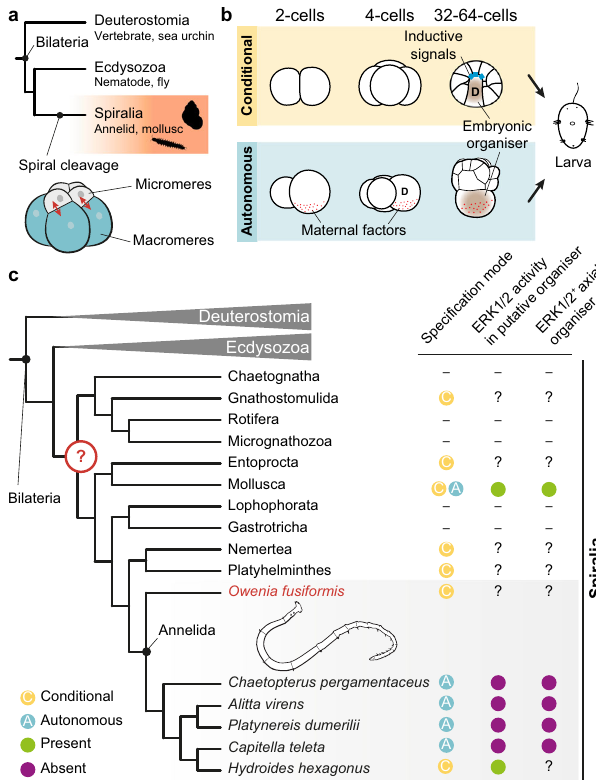
Fig. 1 Conditional and autonomous cell fate speci fi cation occur in spiral cleavage. a Spiral cleavage is a stereotypic developmental mode ancestral to Spiralia (e.g., snails and segmented worms), one of the three major lineages of bilaterally symmetrical animals (Bilateria). Spiral cleavage is characterised by alternating oblique cell divisions (red arrows) along the animal vegetal axis from the 4-cell stage onwards. b Spiral cleaving embryos specify their axial identities and embryonic organiser either conditionally or autonomously. In the conditional mode, the speci fi cation of the posterodorsal identity (D-quadrant; represented as a D) and the embryonic organiser occurs late in cleavage (~32 – 64 cell stages, depending on the species) through inductive signals. The autonomous mode of cell fate speci fi cation, however, relies on differentially segregated maternal factors (red dots) that specify the D-quadrant already at the 4-cell stage (cell with D). Later during cleavage, one cell of the D-quadrant that presumably inherits part of those maternal factors will act as embryonic organiser. c The conditional mode is found in all spiralian lineages exhibiting spiral cleavage and the autonomous mode is only observed in Mollusca and Annelida, which suggests conditional speci fi cation is ancestral. While conditional and autonomous molluscs use the MAP kinase ERK1/2 to establish their body plan, all studied autonomous annelids do not rely on this signalling cascade and knowledge outside Mollusca and Annelida is absent. The ancestral mechanisms controlling spiral cleavage are thus still unknown, which limits our understanding of the evolution of Spiralia. The conditional annelid Owenia fusiformis , as a member of the sister lineage to all remaining annelids, can help to infer ancestral developmental characters to Annelida and Spiralia as a whole. Drawings are not to